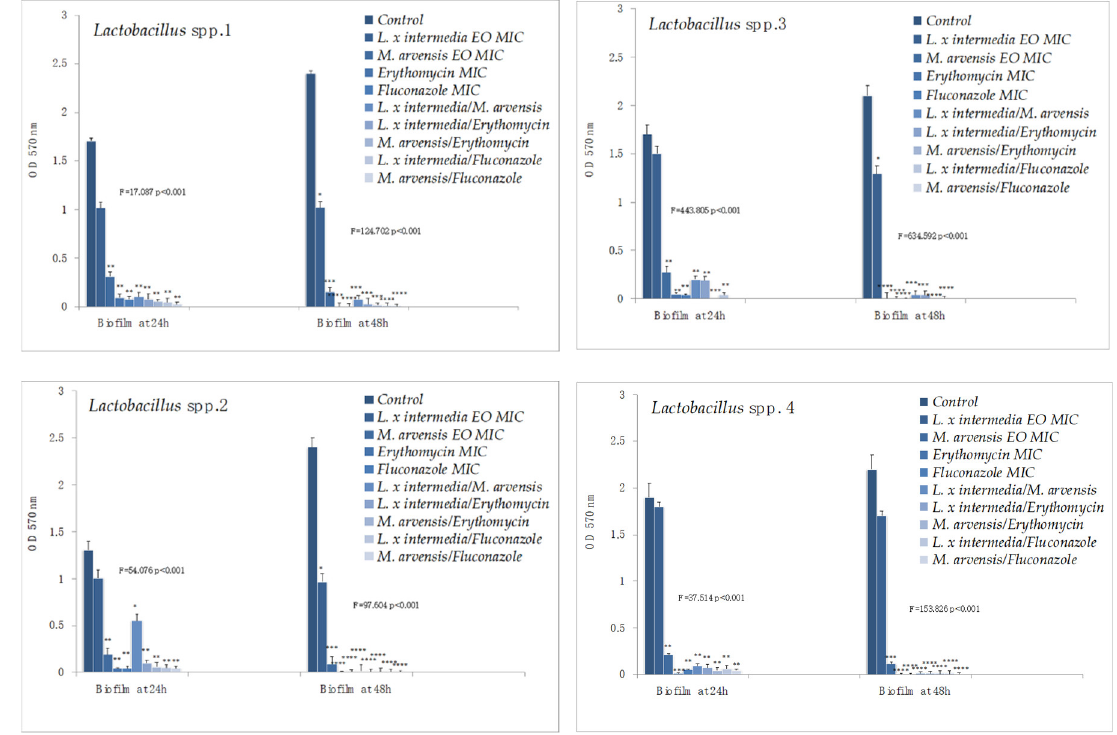
Figure 4. Anti-biofilm activity of L. x intermedia , M. arvensis EOs, antimicrobials (erythromycin and fluconazole), and of different combinations (antimicrobial/EO and EO/EO) against Lactobacillus spp. strains. Results were expressed in OD 570 nm as the arithmetic mean of the three determinations. p -values of < 0.05 (*), p < 0.01 (**), p < 0.001 (***) and p < 0.0001 (****) were considered significant by t -test and ANOVA.